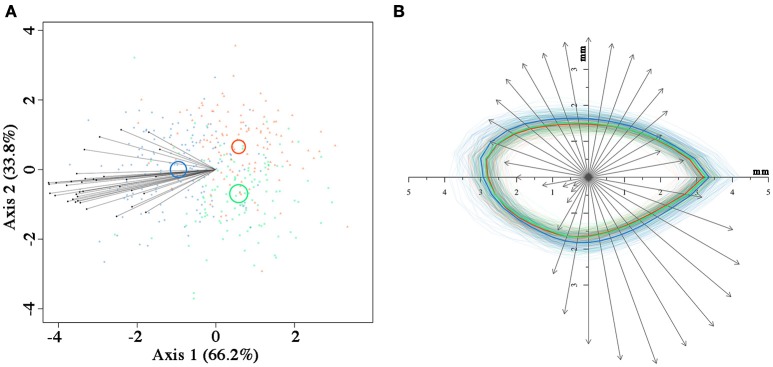
Canonical variate analysis (A) on seed coronal shape using the 36 radii length data, with confidence circles (for α = 0.05) highlighted. Superimposition (B) of the contour of each seed from the three fire cohorts and of the vectors relative to the first canonical axis from (A). The mean contour for each fire cohort is highlighted with thicker lines. In both (A,B), fire cohorts are coded in different colors (FC0: red; FC1: green; FC2: blue).